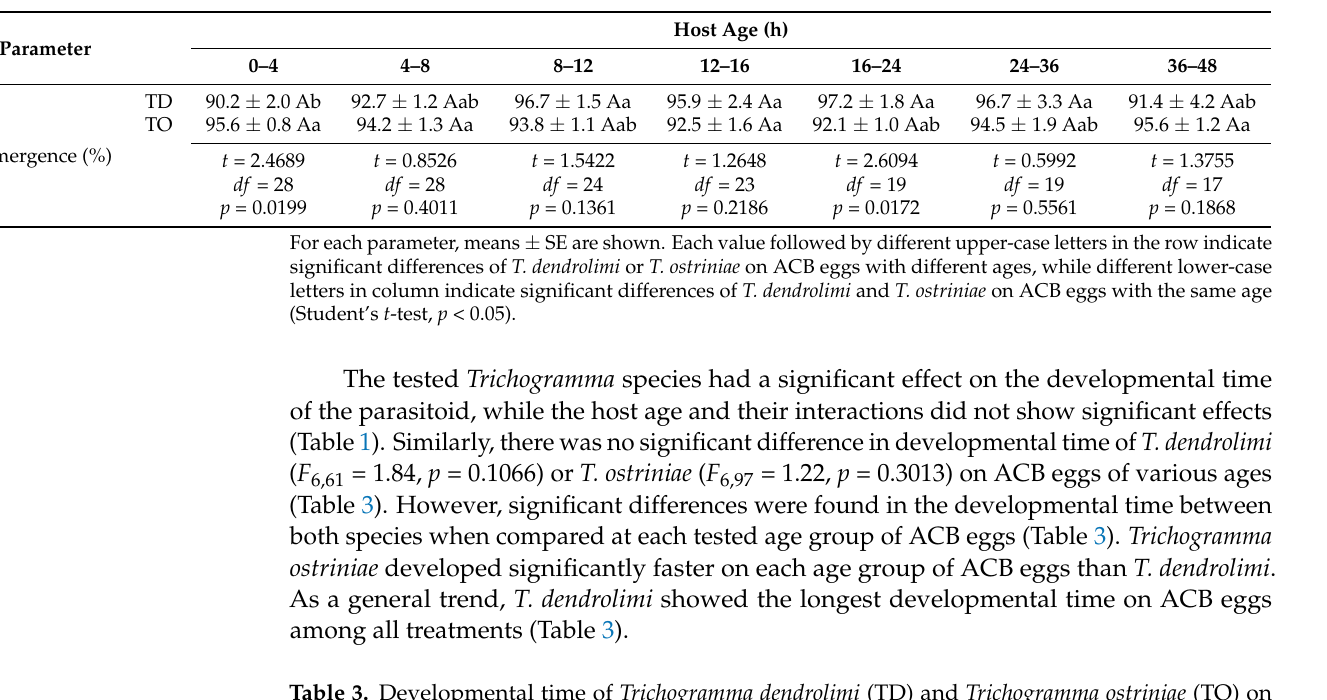
Table 2. Emergence (%) of Trichogramma dendrolimi (TD) and Trichogramma ostriniae (TO) on Asian corn borer (ACB) eggs of different ages.